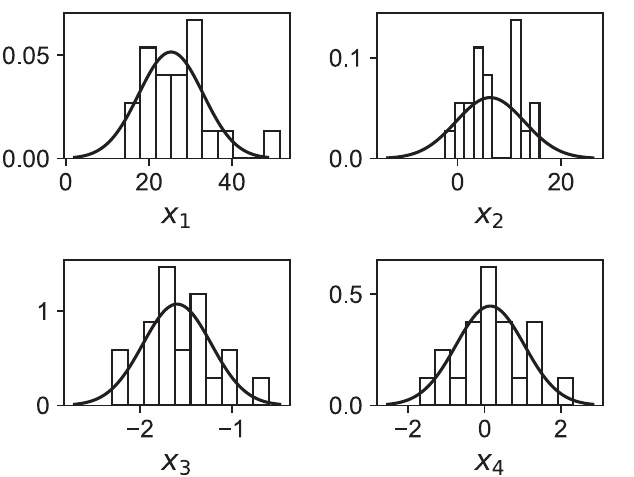
Fig 4. Histograms of the transformed decorrelated variables. The new variables are linear combinations of the fitted ( R 0 , v , k , τ ) parameters as described in the text. They are normalized to unit area and the result of the Gaussian fit is shown in black.